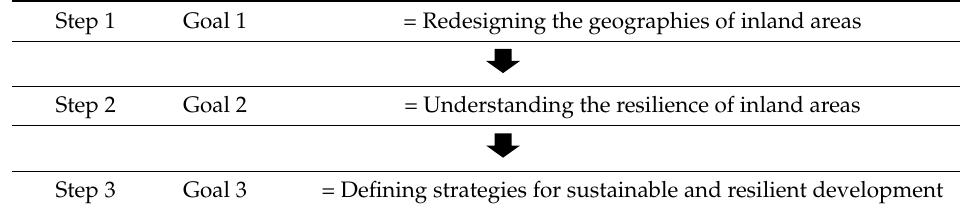
Table 1. Methodological outline of the RI.P.R.O.VA.RE. Project .